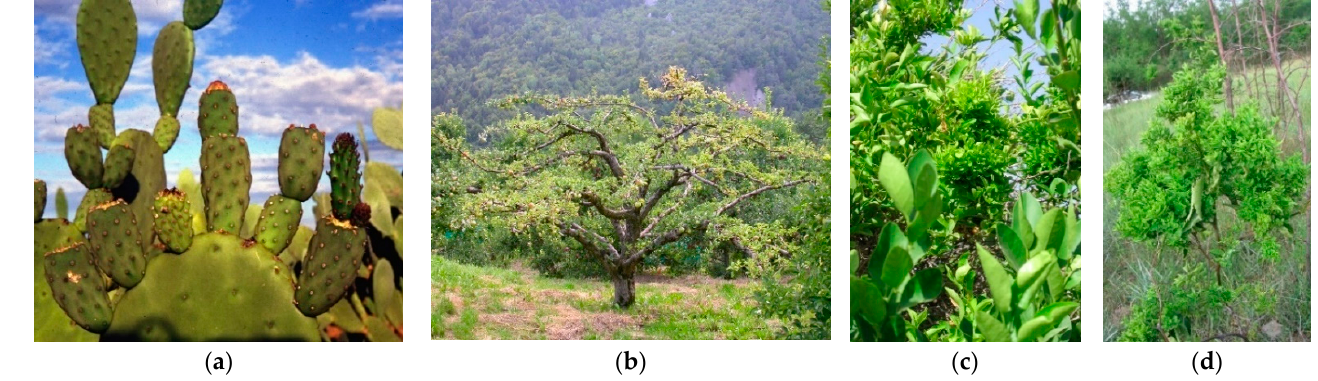
Figure 3. Cactus pear ( Opuntia ficus-indica ) proliferation ( a ), apple proliferation ( b ), citrus witches’ broom ( c ), and jujube witches’ broom ( d ) are associated with the presence of phytoplasmas in diverse areas of the world.